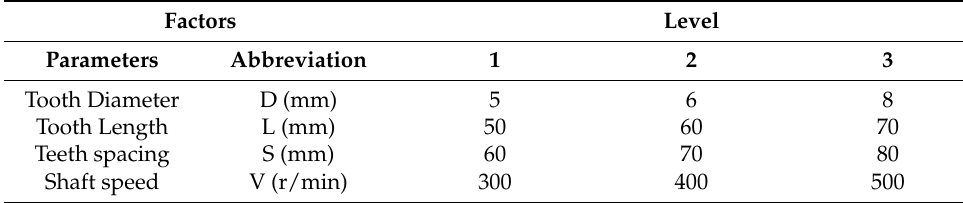
Table 2. Levels and factors affecting LFM cleaning quality.